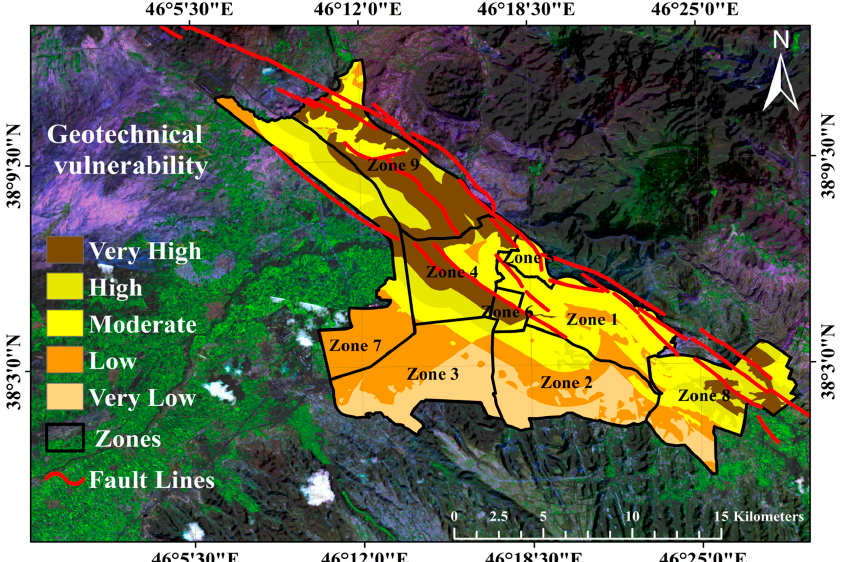
Figure 5. Residential buildings vulnerability distribution showing geotechnical vulnerability in Tabriz municipality. ISPRS Int. J. Geo-Inf. 2018 , 7 , x FOR PEER REVIEW Table 10. The level of residential buildings vulnerability in Tabriz city according to their structural